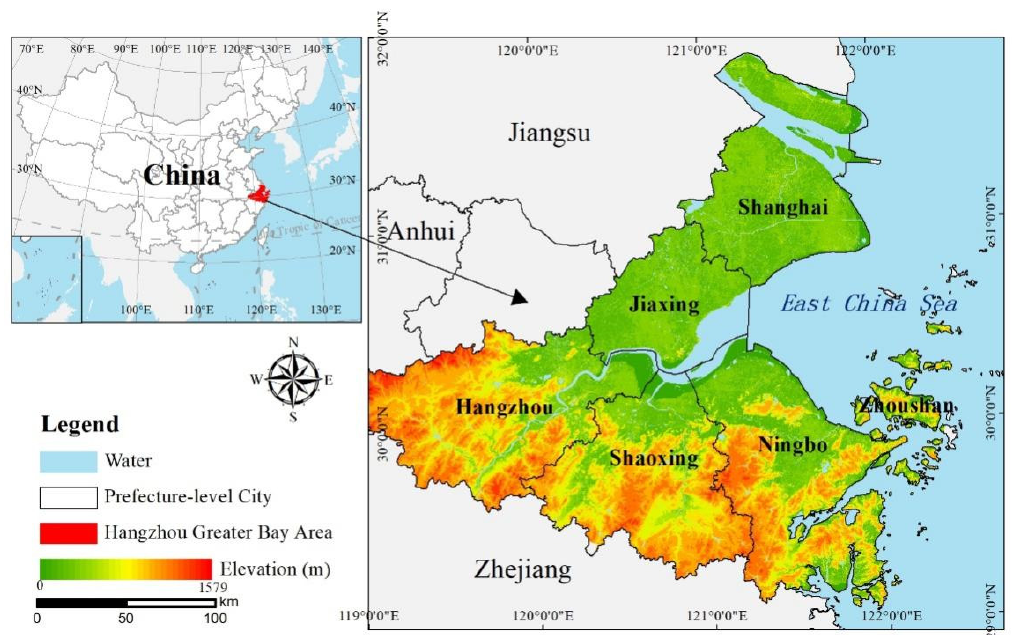
Figure 1. Location and terrain of Hangzhou Greater Bay Area (HGBA).